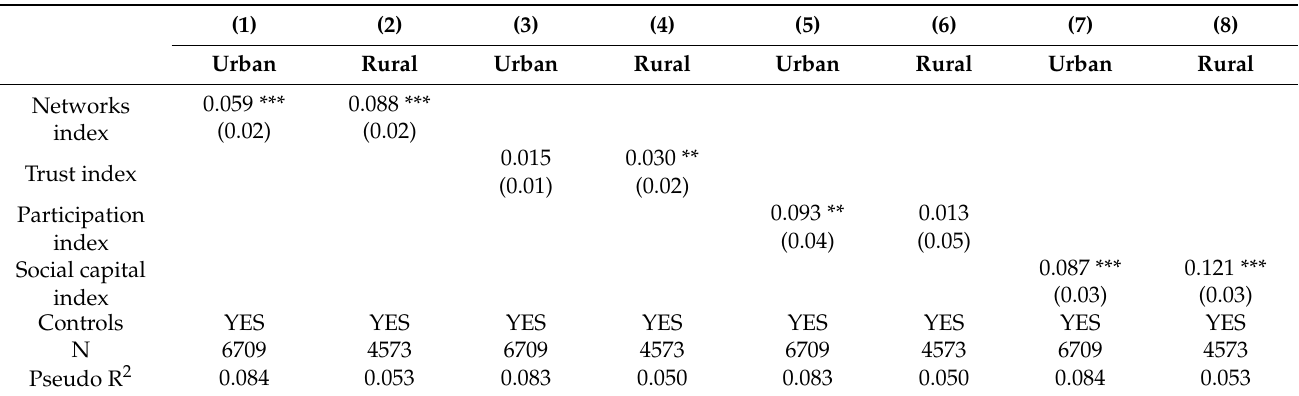
Table 10. The heterogeneous effects of social capital on waste-separation